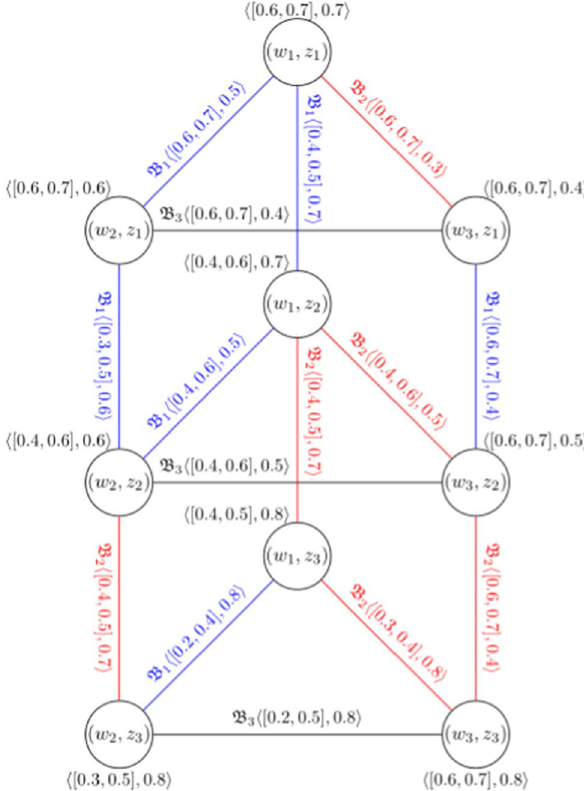
Fig. 9 The maximal product of G and G ′ , 𝔊 = ( 𝔄 , 𝔅 1 , 𝔅 2 , 𝔅 3